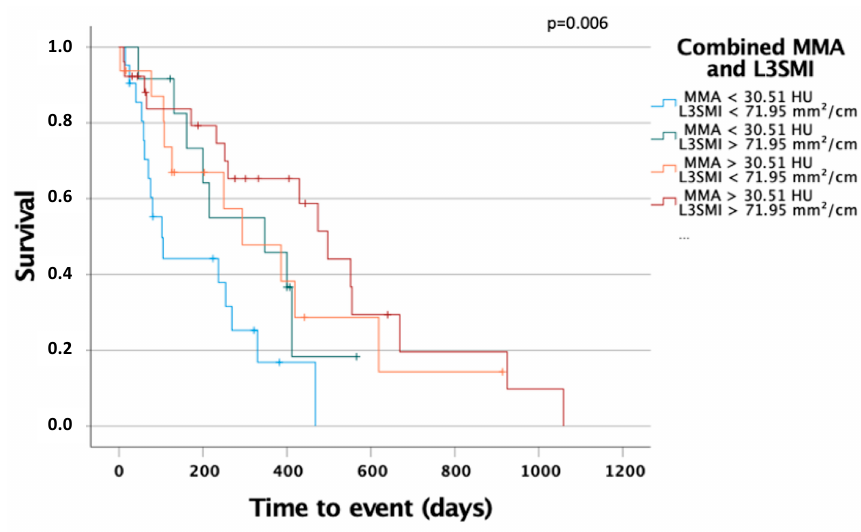
Figure 6. The combination of MMA and L3SMI is a strong predictor for overall survival in patients with palliative treatment for CCA. Patient with MMA above 30.51 HU and L3SMI above 71.95 mm 2 /cm had significantly improved OS compared to patients with both markers under their optimal cut-off or combinations.